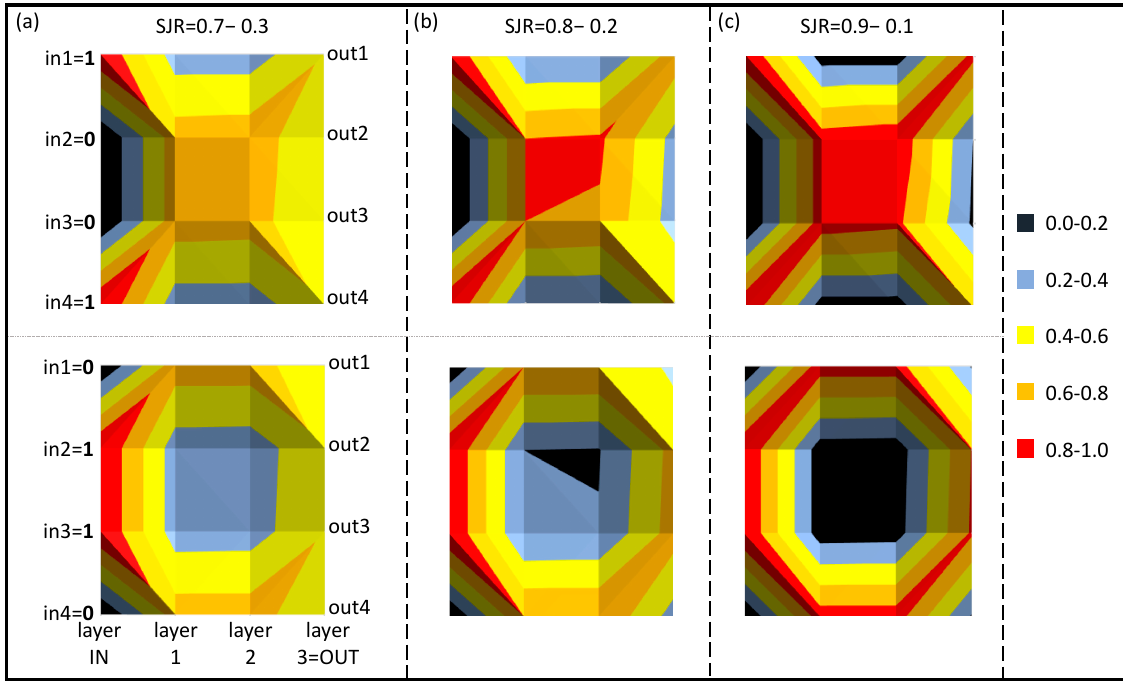
Figure 5. Represents the energy flow in a three-layer network learning two input numbers, 1 − 0 − 0 − 1 and 0 − 1 − 1 − 0, for the three SJRs: ( a ) SJR = 0.7 − 0.3; ( b ) SJR = 0.8 − 0.2; ( c ) SJR = 0.9 − 0.1.